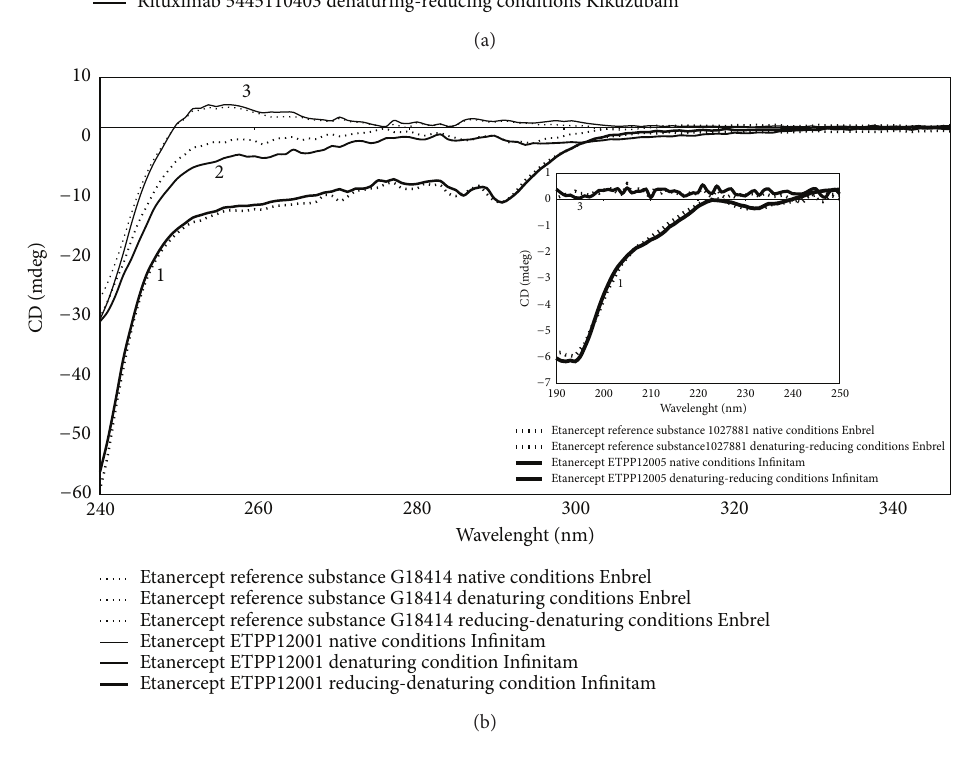
Figure 1: Far- and near-UV CD spectra of (a) Rituximab and (b) Etanercept products under (1) native, (2) denaturing, and (3) denaturing- reducing conditions. Dotted lines represent Mabthera (Rituximab) and Enbrel (Etanercept), while continuous lines represent Kikuzubam (Rituximab) and Infinitam (Etanercept) representative batches. Main plot shows near-UV CD spectra (240–350 nm) and graphic insert shows far-UV CD spectra (190–300 nm). Near- and Far-UV characteristic spectra of Rituximab are shown in (a) and insert shows antiparallel 𝛽 - sheets coming from CH 1 , CH 2 , and CH 3 and V L and V H domains. Etanercept spectra (b) show an irregular structure directed probably by complex and diverse glycan substituents. Each sample was run in triplicate; average is represented as single spectrum (details are described in Section